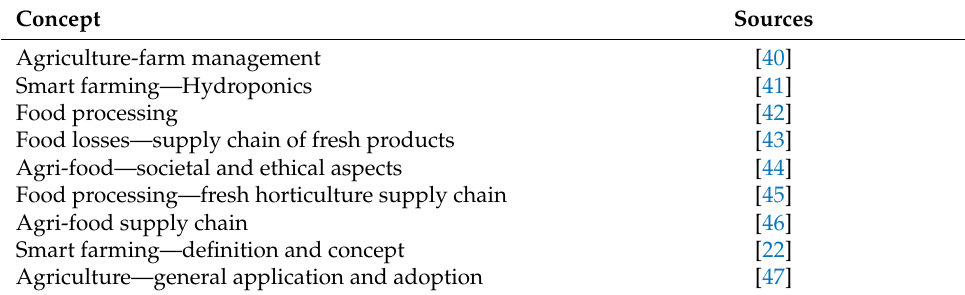
Table 1. Previous review studies on digital twin in